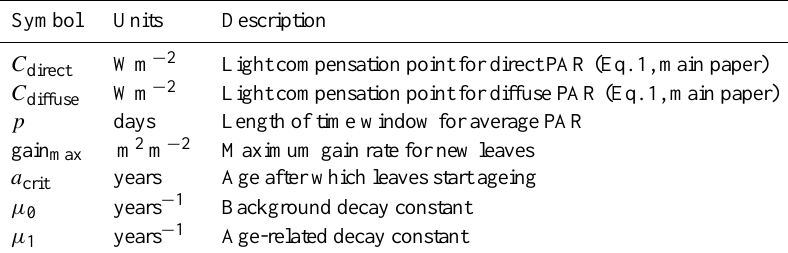
Table 1. Model parameters